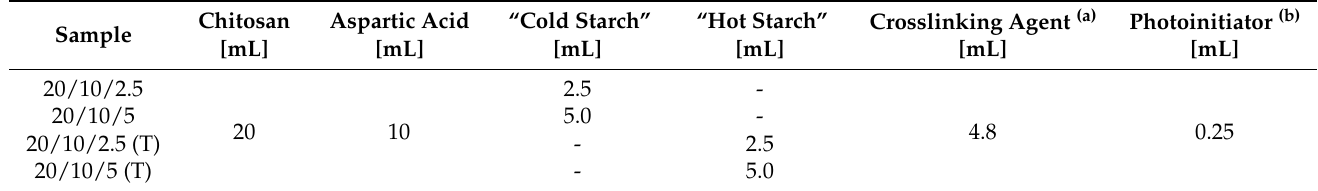
Table 2. Compositions of starch-modified hydrogels.